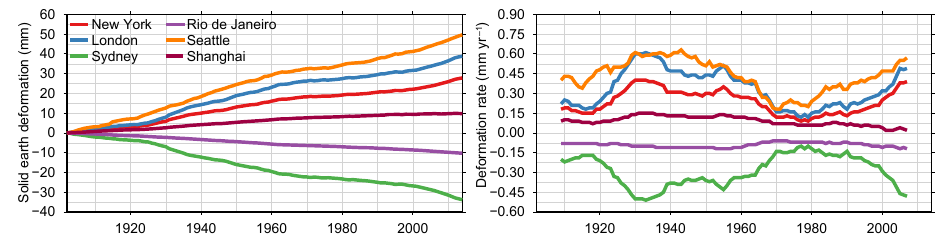
Figure 3. Time series of vertical deformation (left panel) and 15-year average rates (right panel) at selected coastal cities due to global ice mass changes. The locations of the cities are indicated by diamonds in Fig. 1a, following the same colour